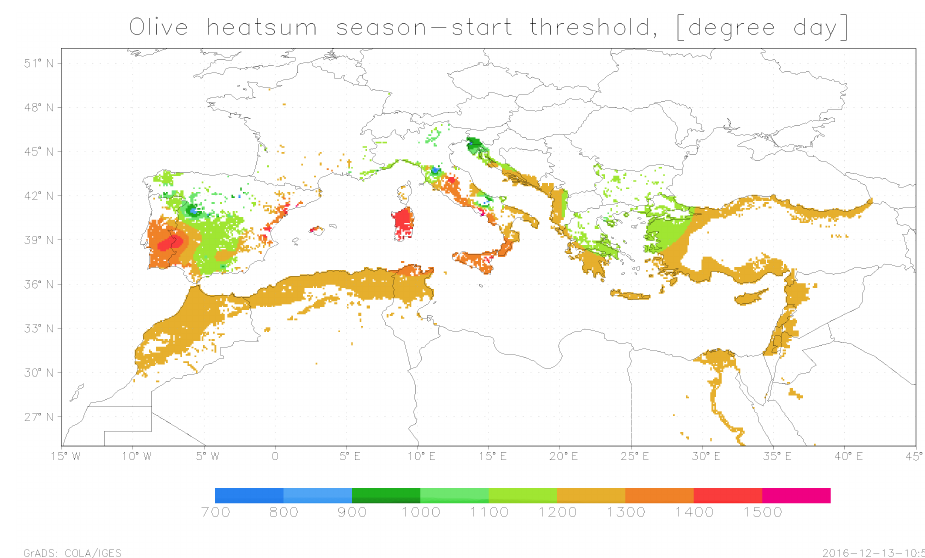
Figure 2. Heat-sum threshold for the start of the season. Unit = [ ◦